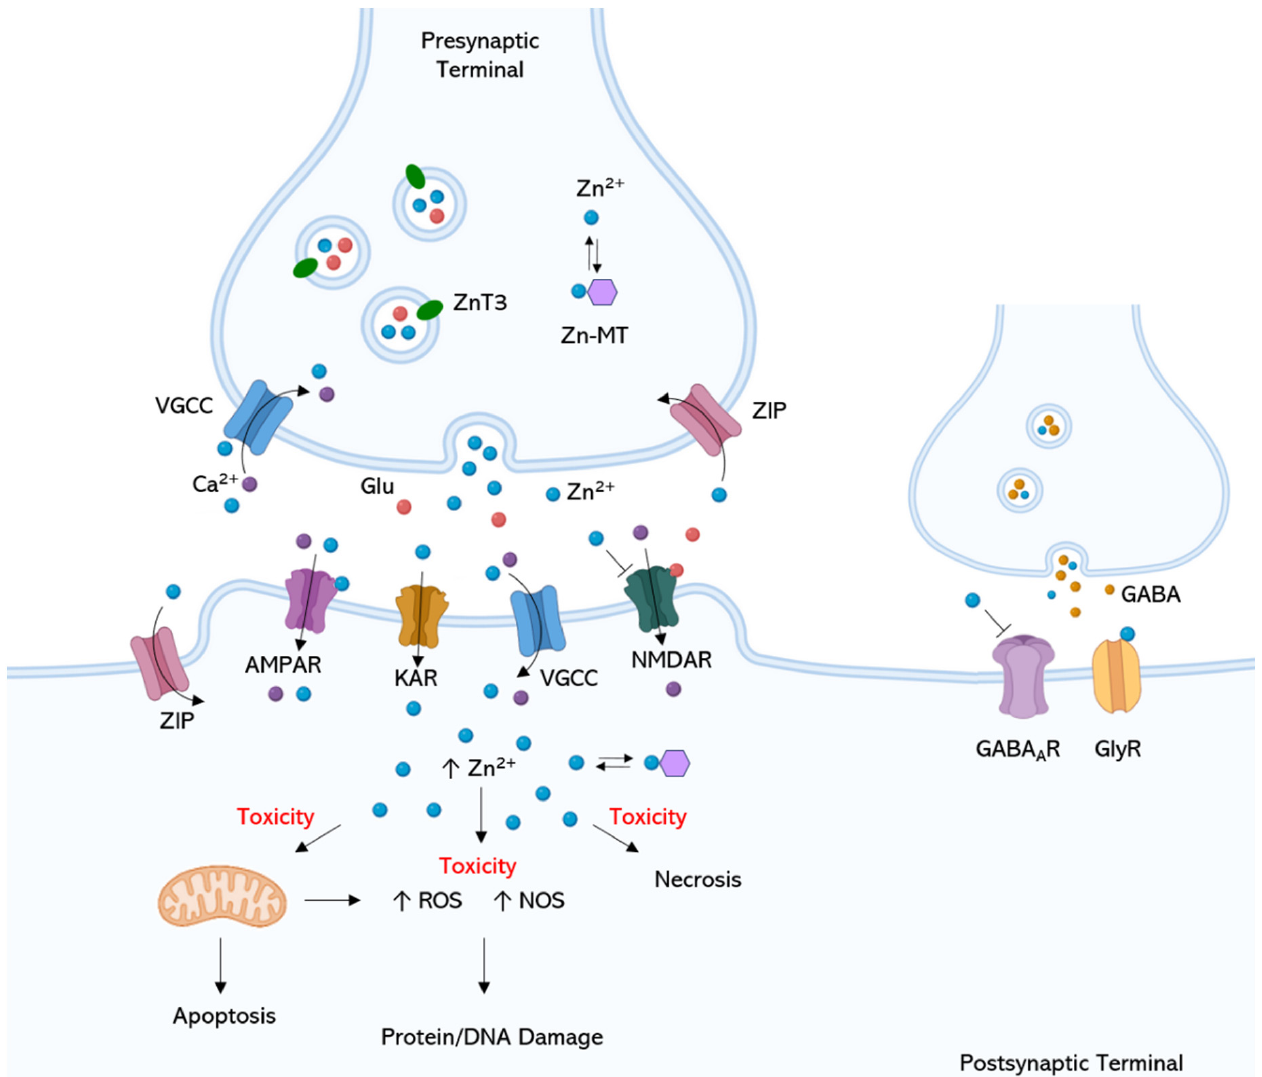
Figure 2. Physiological and pathological neuromodulation of Zn-containing pre- and postsynaptic neurons. Most vesicular Zn co-localizes with glutamate in subsets of glutamatergic zinc-enriched neurons, and it is also contained in the synaptic vesicles of subpopulations of glycinergic and GABAergic neurons. Zn 2+ -level regulation between cellular compartments, organelles, and extracellular space is ensured by ZIP and ZnT protein families, and by metallothioneins (MTs), which buffer cytoplasmic Zn 2+ , functioning as a temporary store for cellular Zn 2+ . In the presynaptic terminals, Zn 2+ is transported into presynaptic vesicles by the Zn transporter ZnT3. During synaptic transmission, free Zn is released in the synaptic cleft, where it may be recycled back into the presynaptic boutons by ZIP/Zn 2+ transporters or modulate excitatory (NMDA, AMPA) and inhibitory (GABA, glycine) amino acid receptors of the postsynaptic terminal; Zn can inhibit GABAAR and NMDAR, and potentiate/inhibit AMPAR and GlyR at low/high concentrations, respectively. Extracellular Zn can also alter the excitability of neurons through effects on voltage-gated ion channels (e.g., VGCC), affecting ions’ influx and neurotransmitter release. Ion channels and AMPAR/KAR allow synaptically released Zn to enter presynaptic and postsynaptic neurons to modulate intracellular Zn signaling functions. Excessive Zn 2+ accumulation inside postsynaptic cells, as per excitotoxic stimulation, can lead to a series of toxic effects involving mitochondrial dysfunction and ROS/NOS production, eventually leading to oxidative damage to proteins and DNA, neuronal apoptosis, and/or necrosis. Glu, glutamate; GABA A R, GABA A receptor; NMDAR, NMDA receptor; AMPAR, AMPA receptor; GlyR, glycine receptor; VGCC, voltage-gated calcium channel; KAR, kainate